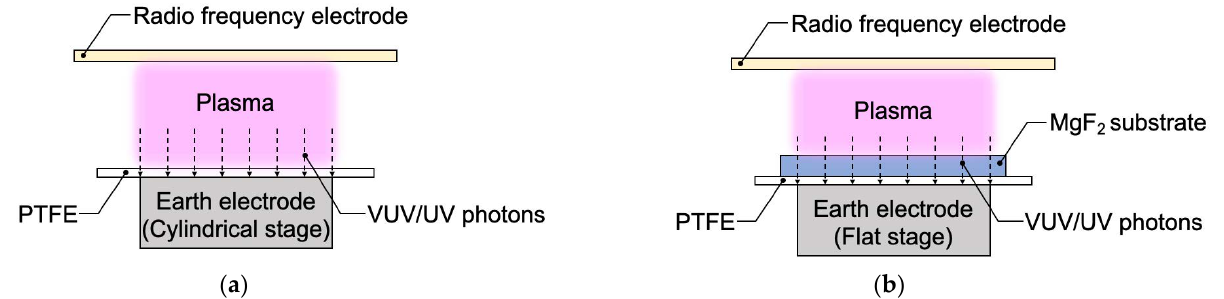
Figure 1. Schematic depicting the irradiation with vacuum ultraviolet (VUV) and UV photons to the PTFE surface during plasma treatment ( a ) without using an MgF 2 substrate and ( b ) using an MgF 2 substrate.